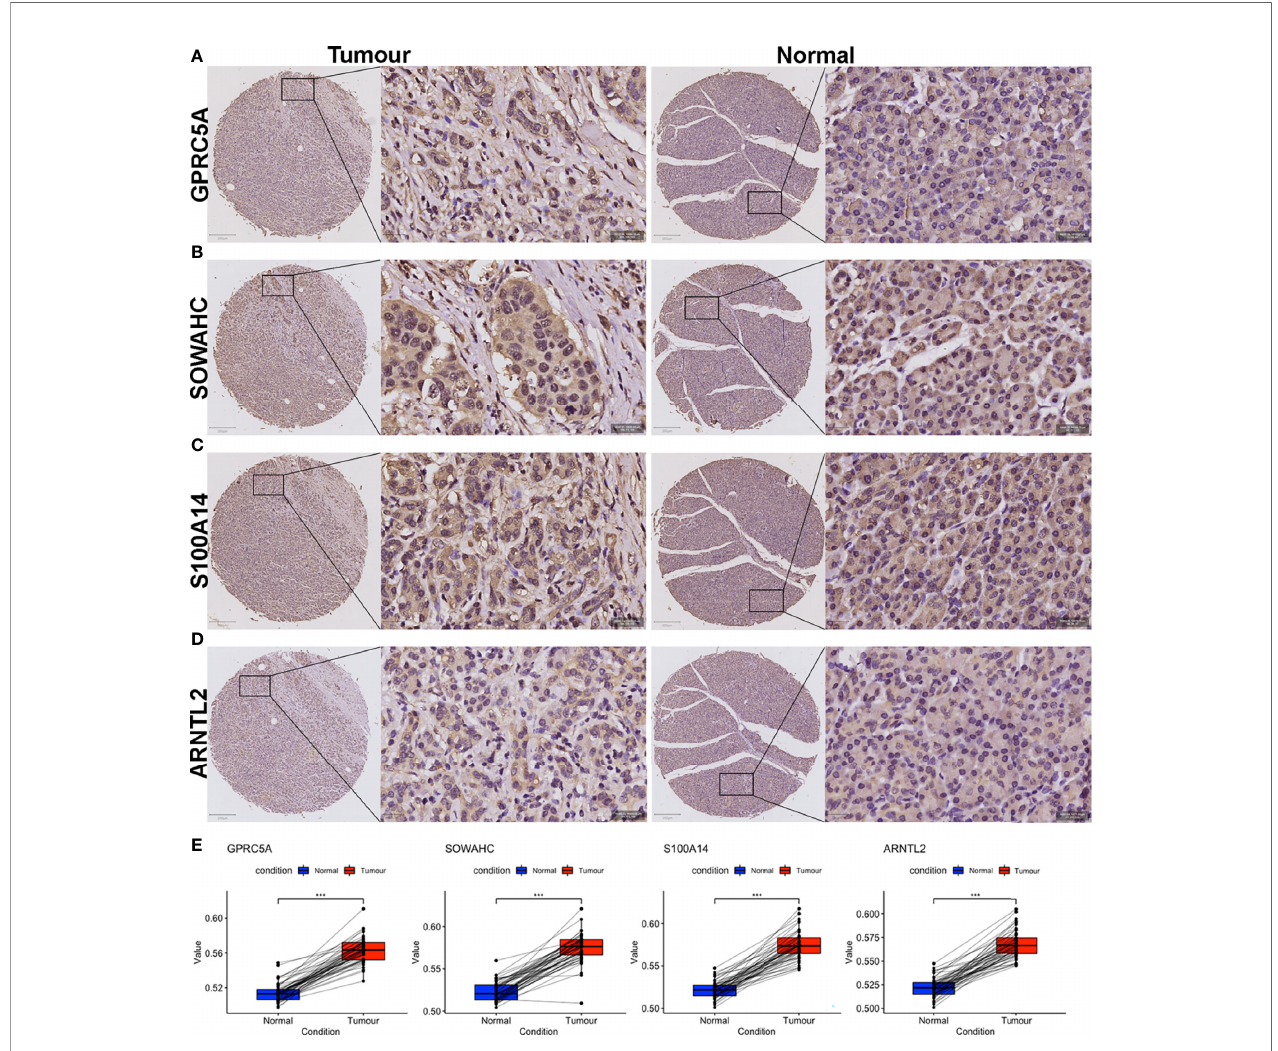
FIGURE 11 | IHC evaluation of PACA samples collected from our center. (A – H) Expressions of the four MDG proteins in tumorous and corresponding para-tumor tissues. (I) The MDG-corresponding protein levels were up-regulated in PACA tissues compared to non-cancerous tissues.